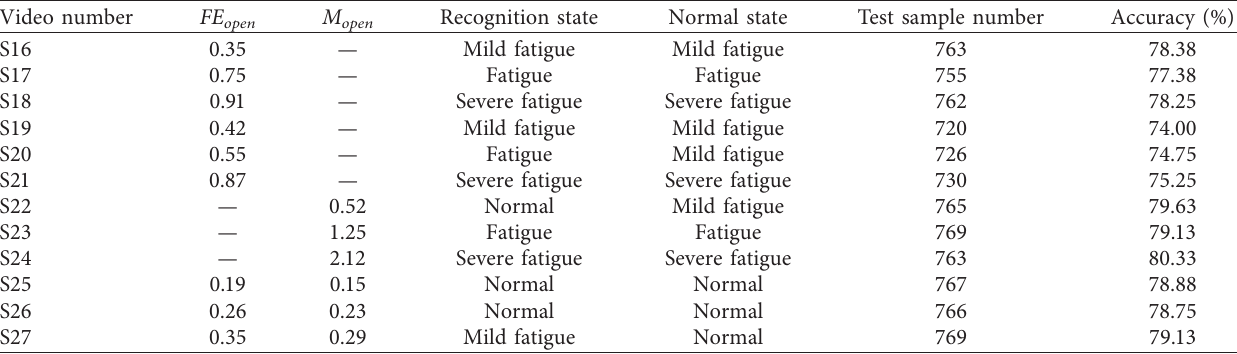
Table 2: Test results of eye and mouth movements.